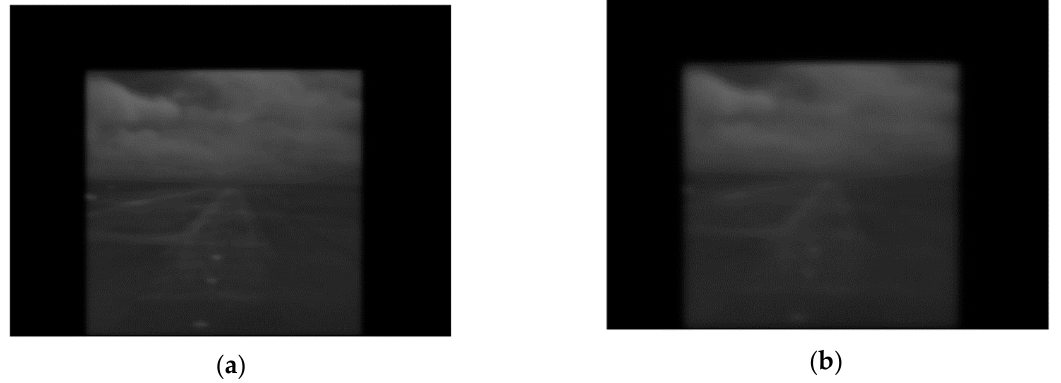
Figure 5. ( a ) EVS image with intermediate turbulence ( k = 0.001) and ( b ) EVS images with severe turbulence ( k = 0.0025).